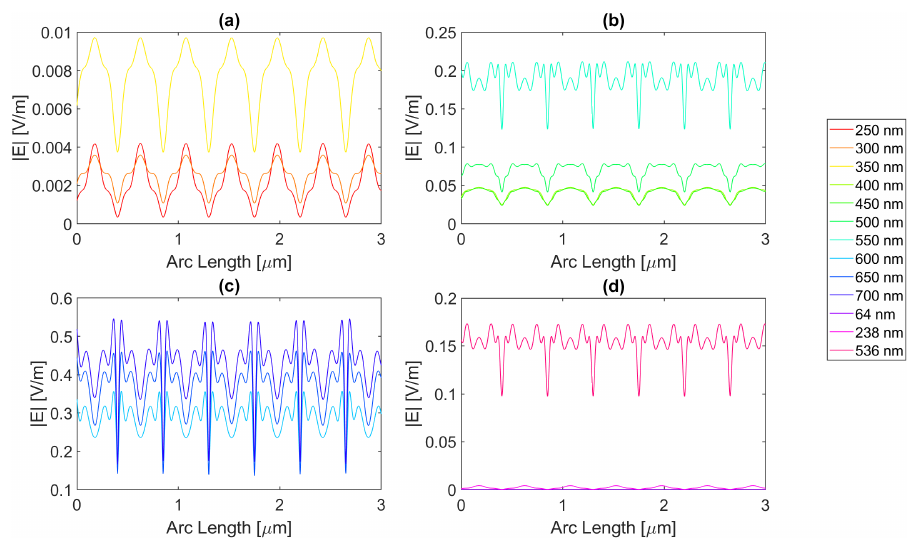
Figure 17. Electric field for the gold circular nanostructure with 200 nm radius—Probe 1. For copper, the electric field peak is similar to gold, and even at the same wavelength, it is 5.45 × 10 − 1 V/m, with a 1.33 × 10 − 6 integral. The results of the studied wavelengths can be found in Tables A10, A11, and A12 for probes 1, 2, and 3, respectively. For the range of wavelengths between 500 and 700 nm, the electric field intensity increases from probe 1 to probe 2; however, the field integral always decreases. In the third probe at 700 nm, the intensity also increases, while the integral decreases for all wavelengths.